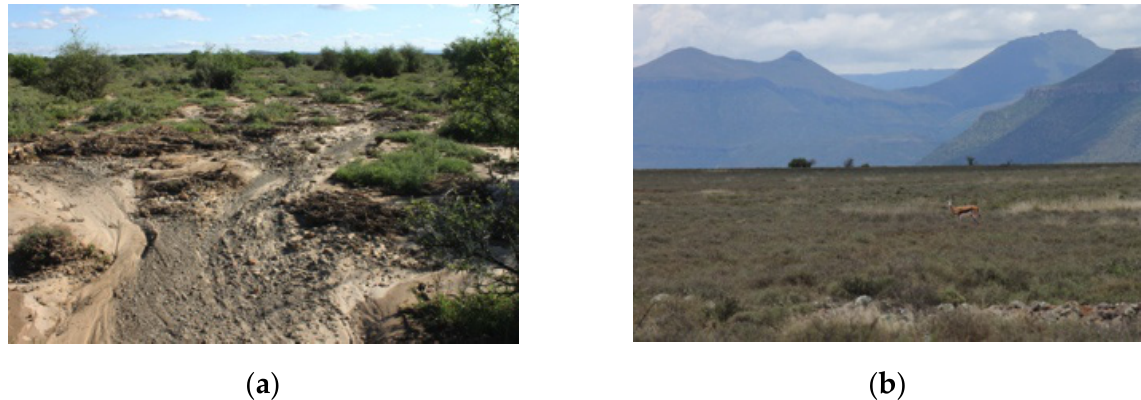
Figure 5. ( a ) Floodout formation in the lower zone; ( b ) Topography of the catchment indicating mountains leading into